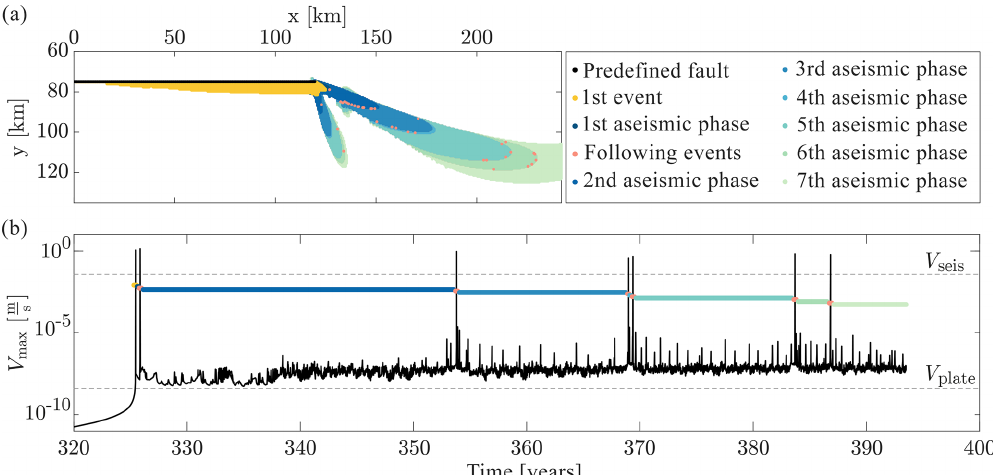
Figure 5. Temporal and spatial evolution of model RT with indications of aseismic and seismic fault growth stages in color. (a) Accumulated plastic strain exceeding ε p > 4 × 10 − 5 for different growth stages. (b) Logarithm of the global maximum slip velocity log (V max ) . A video of the simulation can be found in the Video supplement (video model RT, 116 Mb, https://www.research-collection.ethz.ch/bitstream/handle/ 20.500.11850/397242/Video_Model_RT_reduced.mov?sequence=22&isAllowed=y, last access: 28 May